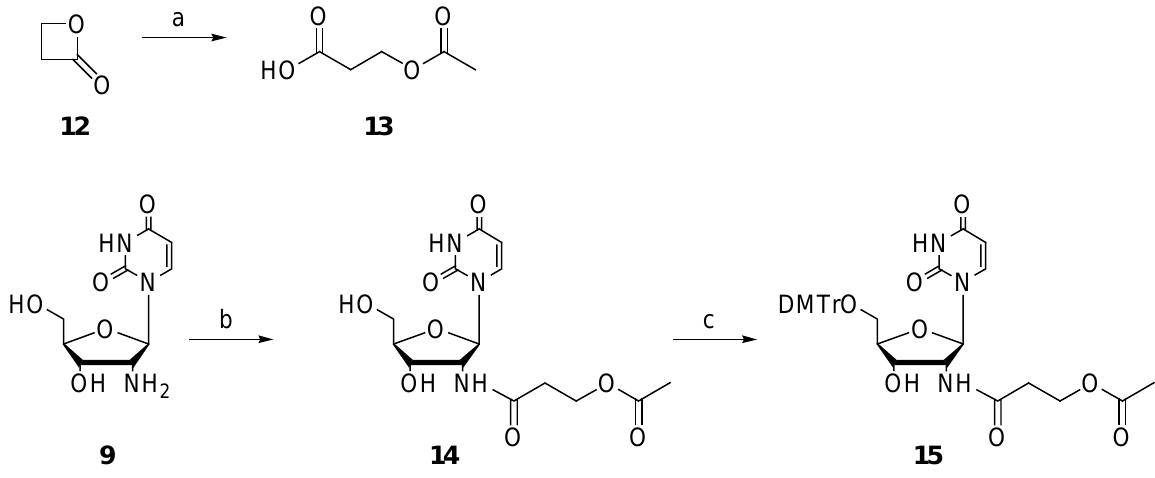
Scheme 3 : Synthesis of the hydroxyl-modified nucleoside building block 15